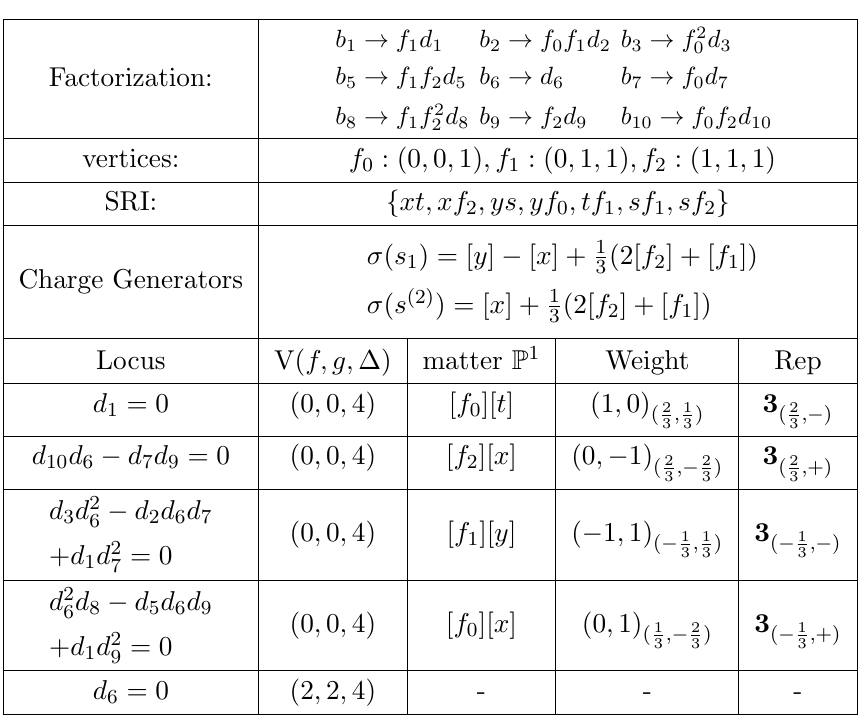
Table 15 . Summary of SU(3) top